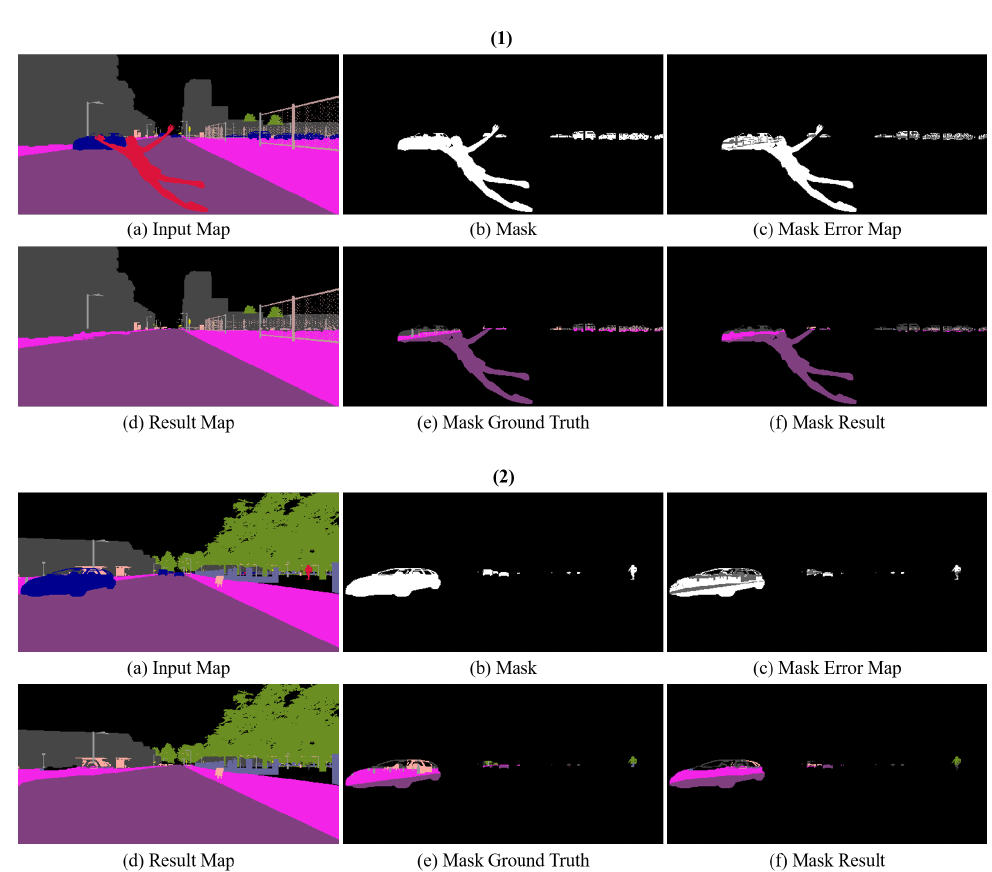
Figure 7. Detailed results of the purposed semantic segmentation inpainting network (SSIN) on Media Integration and Communication Center Semantic Road Inpainting (MICC-SRI)